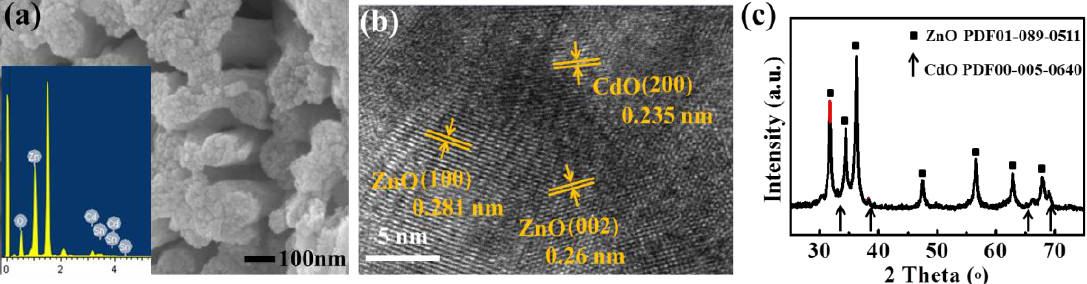
Figure 6. Characterizations of CdO-activated n-type Sn-doped ZnO: ( a ) SEM image and EDS spectrum (inset); ( b ) HRTEM and FFT (inset); and ( c ) XRD pattern.